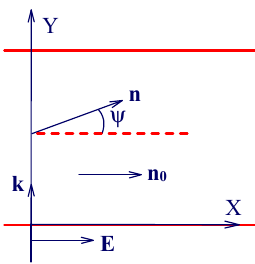
Figure A1. The schematic of the interaction of NLCPwith linearly polarized light beam incident normally on the sample with initial uniform planar alignment characterized by the director n 0 . E and k are the electric field and wave vector of the incident light, and ψ is the angle of the director rotation.